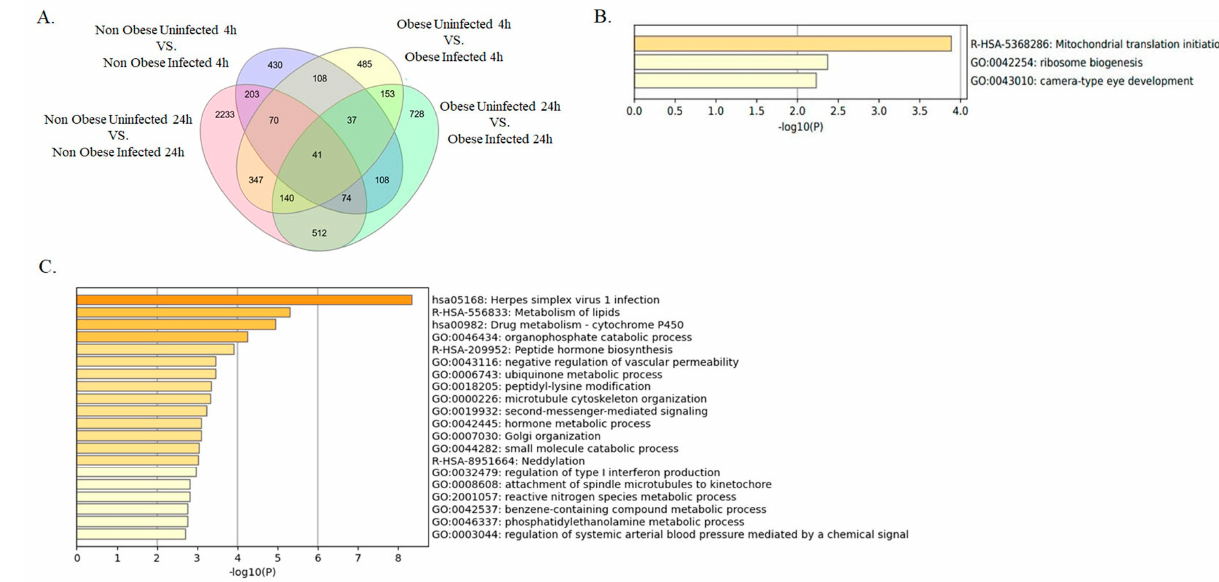
Figure 3. Core transcriptome of bronchial epithelial cells during SAR-CoV-2 infection. ( A ) Venn diagram of intersecting DEGs from non-infected, infected, bronchial epithelial cells from non-obese and obese at 4 and 24 h post-infection. ( B ) Enrichment analysis of the 41 genes found in the intersection of all groups of Venn diagram. This being the core transcriptomic of infected vs. non-infected (non- obese and obese). ( C ) Enrichment analysis of the 728 genes found in the obese uninfected 24 h vs. obese infected 24 h group of the Venn diagram.